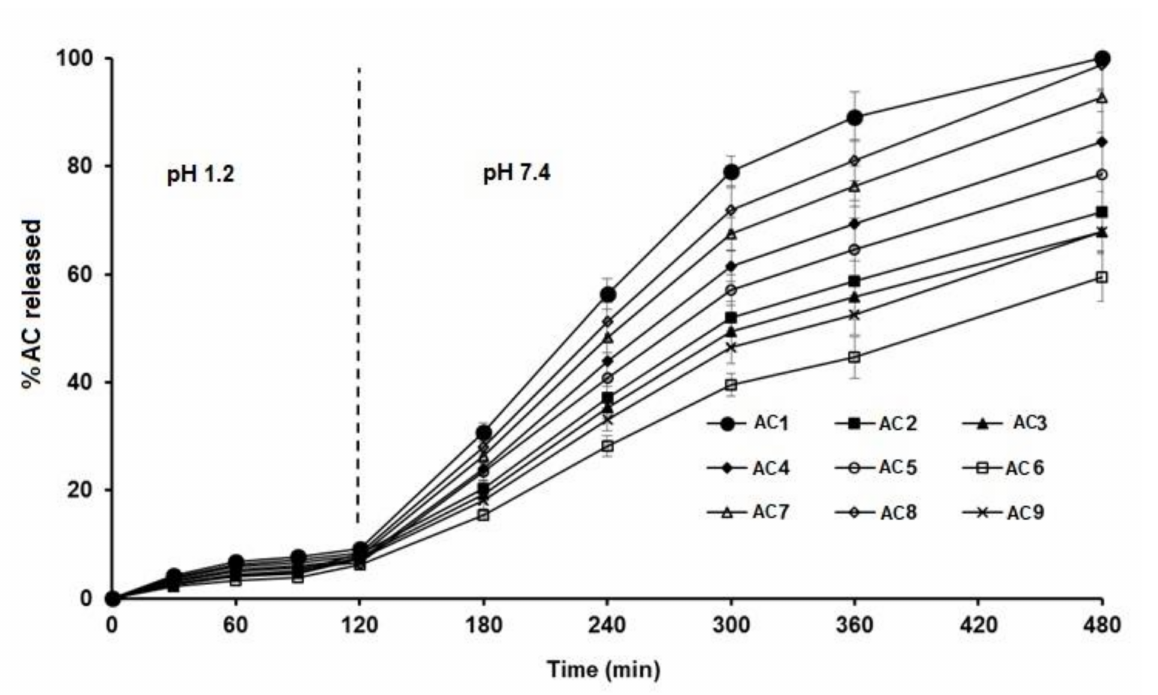
Figure 4. In vitro release profiles of AC from different sustained-release matrix pellet